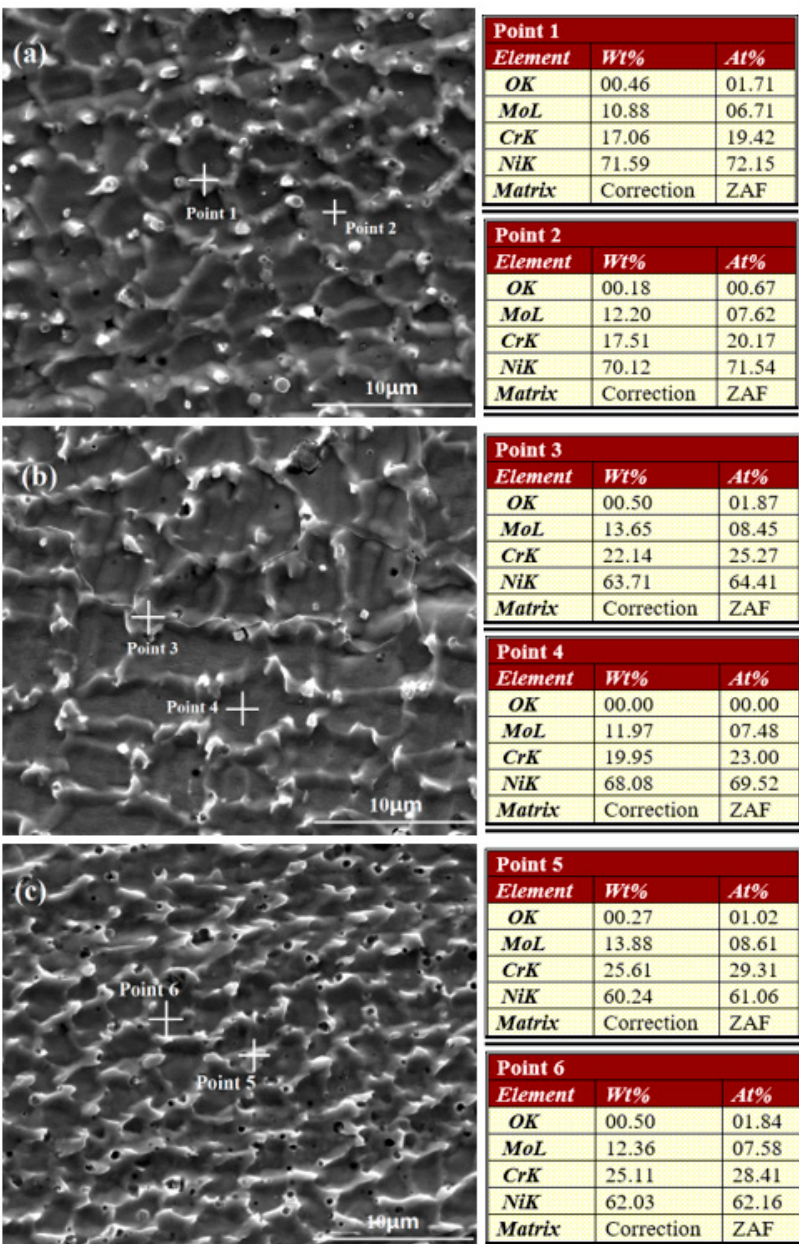
Figure 4. Corrosion Morphologies and elemental content analysis of Ni-Cr-Mo alloy coatings after immersion testing: Cr18 ( a ), Cr22 ( b ), and Cr26 ( c ).